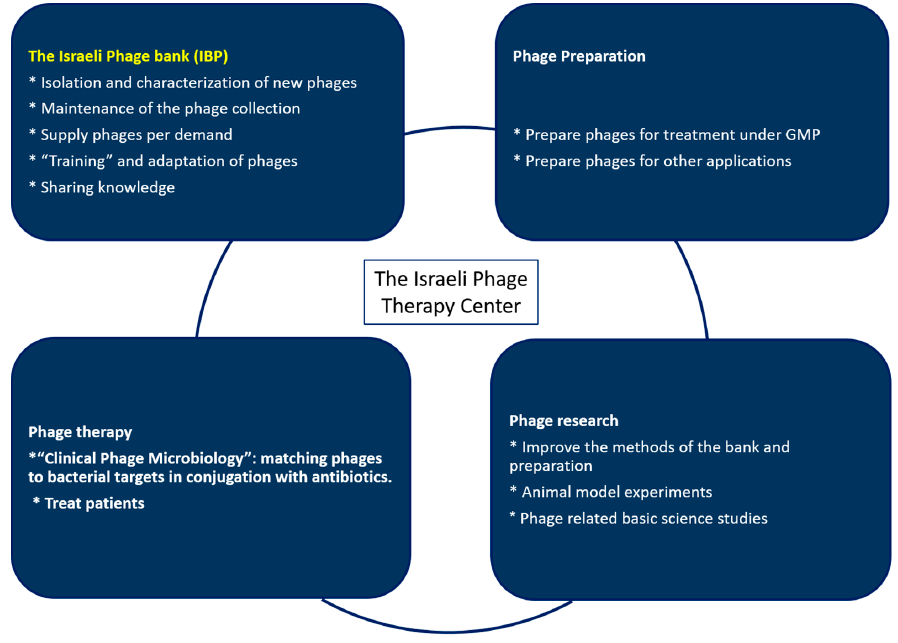
Figure 1. The future phage therapy center’s mode of operation. Figure 1 . The future phage therapy center's mode of operation.